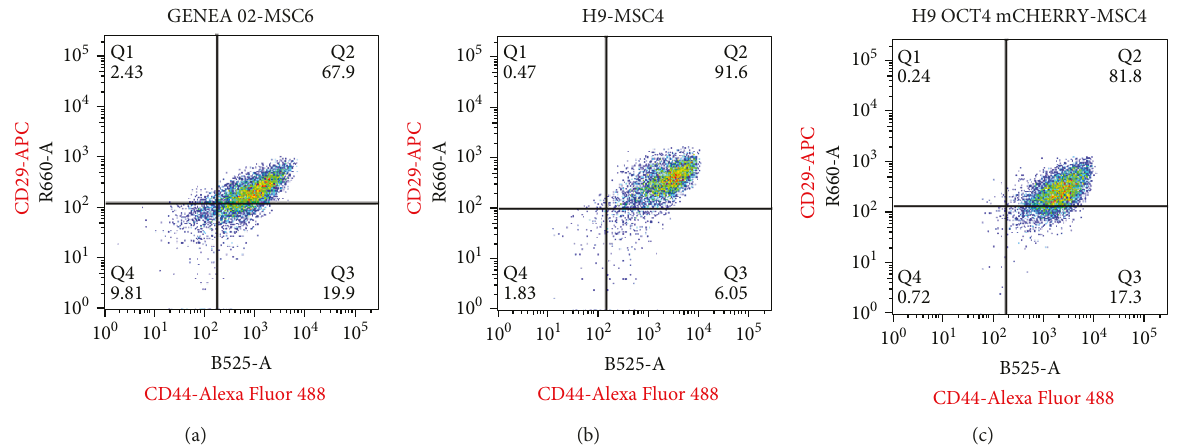
Figure 3: Flow cytometry dot plots showing the coexpression of CD44 and CD29 in GENEA 02-MSC6 (a), H9-MSC4 (b), and H9 OCT4 mCHERRY-MSC4 (c) cells. The gates denoting positive expression of CD44 and CD29 were selected by exclusion of greater than 99% of events appearing in the isotype control pattern. CD44 and CD29 were found to be strongly coexpressed in both iPSC- and ESC-derived MSC lines examined. Each plot represents 10.000 FACS events.